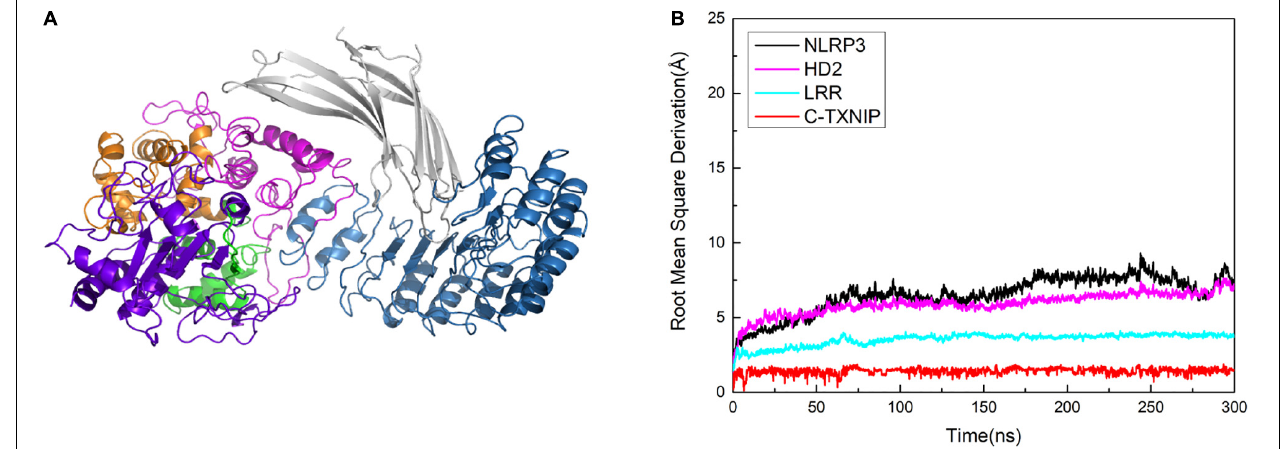
FIGURE 8 | (A) Model of NLRP3 bound to TXNIP containing only C-TXNIP. (B) Root mean square derivation (RMSD) curves of NLRP3 (black), HD2 (magenta), LRR (cyan), and C-TXNIP (red) in this model after simulation at 0, 50, 100, 200, 250, and 300